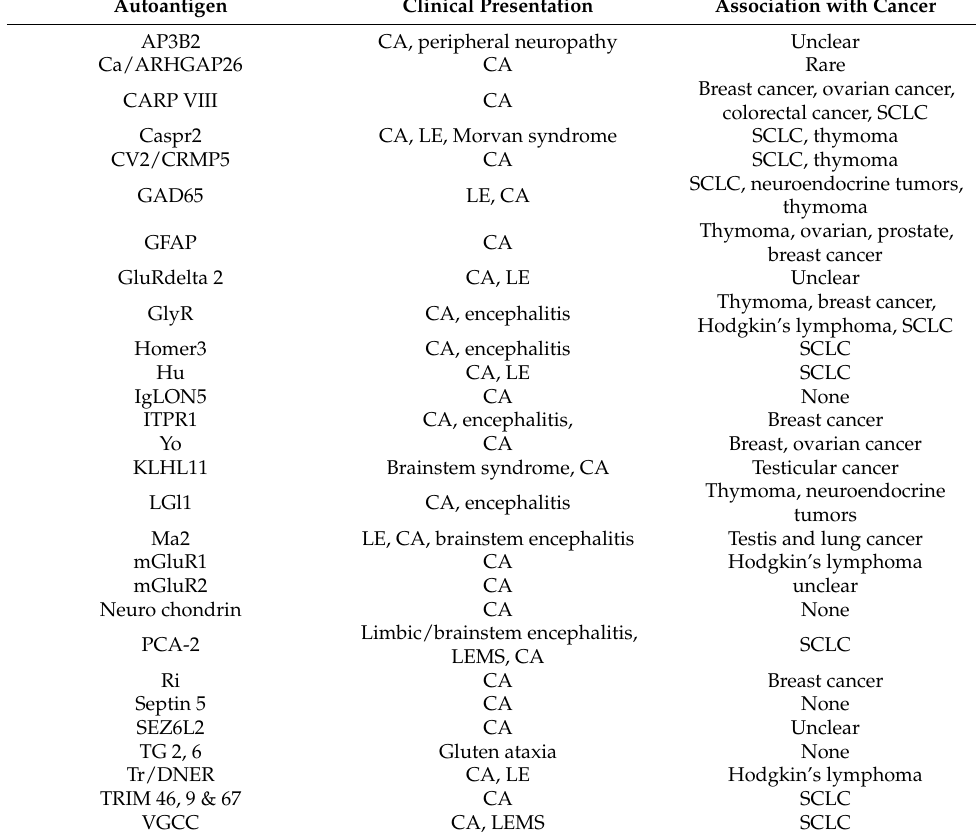
Table 1. Autoantibodies associated with autoimmune CA (compiled from